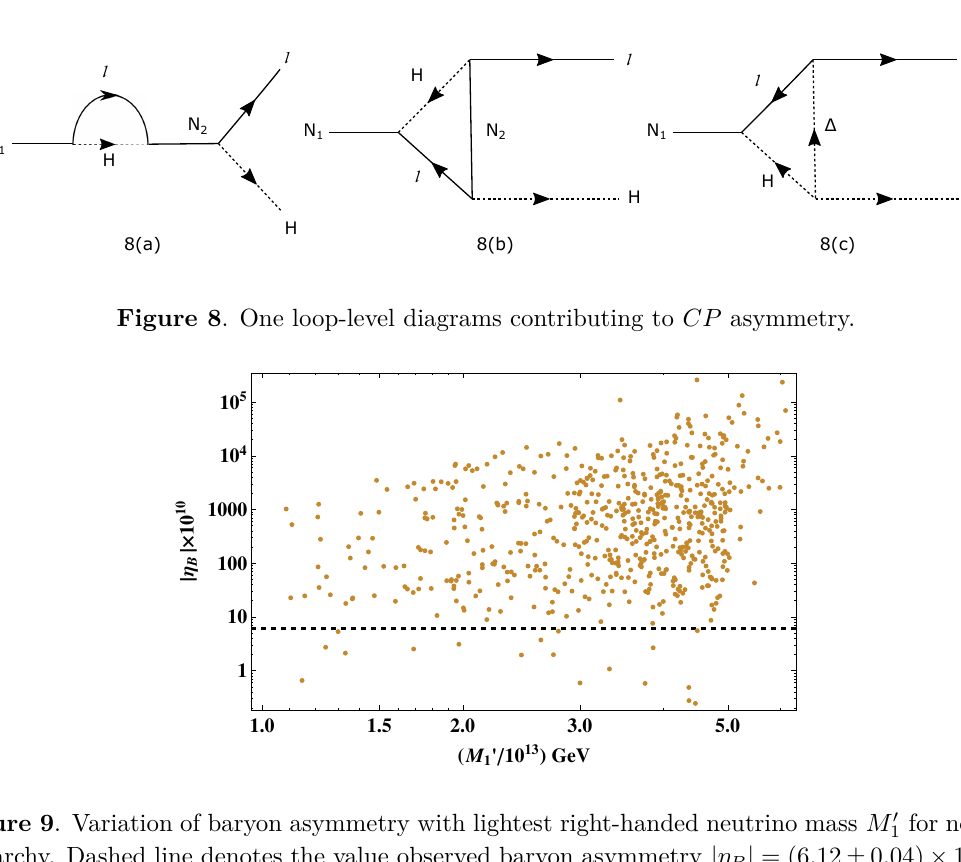
Figure 9 . Variation of baryon asymmetry with lightest right-handed neutrino mass M 0 hierarchy. Dashed line denotes the value observed baryon asymmetry | η